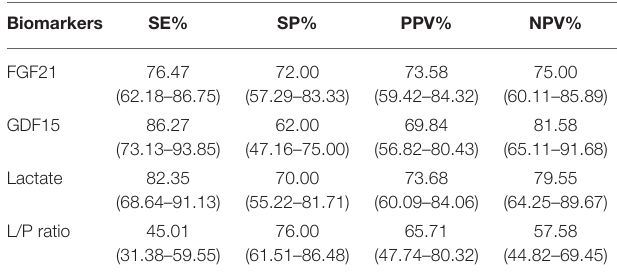
TABLE 3 | Sensitivity (SE), specificity (SP), positive predictive value (PPV), and negative predictive value (NPV) of each biomarker. (95%